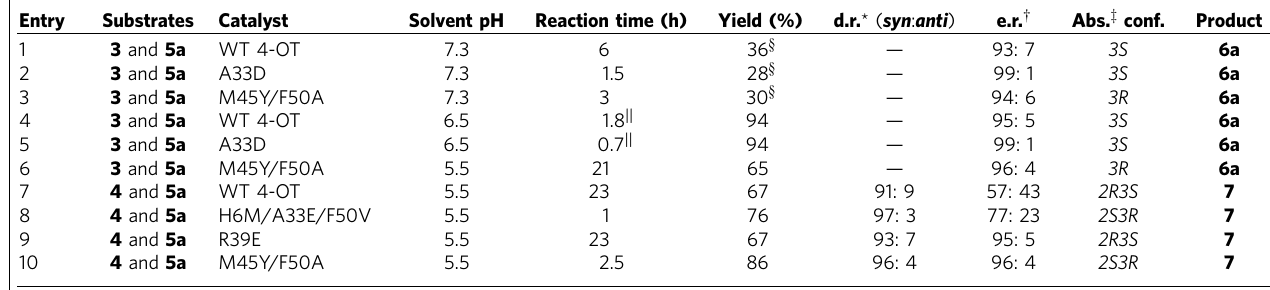
Table 1 | Preparative scale Michael-type addition reactions of aldehydes (3 or 4) to trans -nitrostyrene (5a) catalysed by wild-type 4-OT or 4-OT mutants